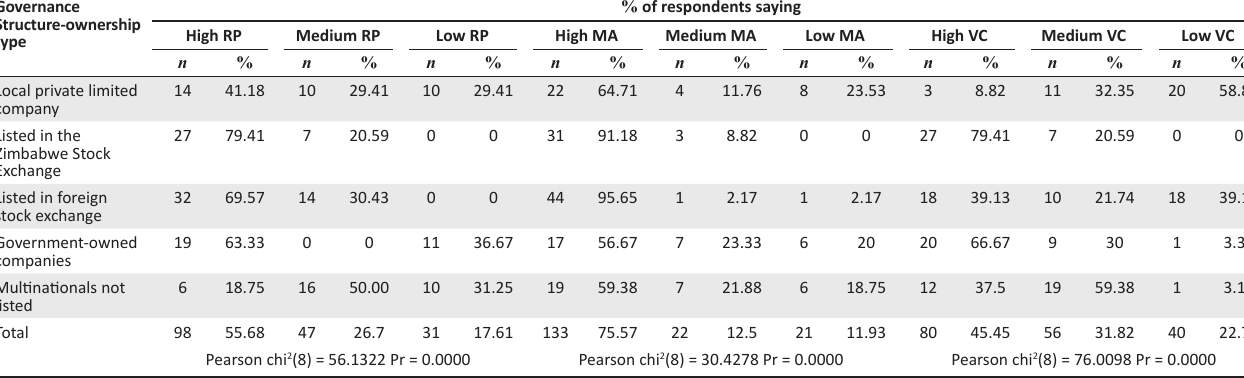
TABLE 4: Retirement plan, medical assurance, conflictive situation. Governance